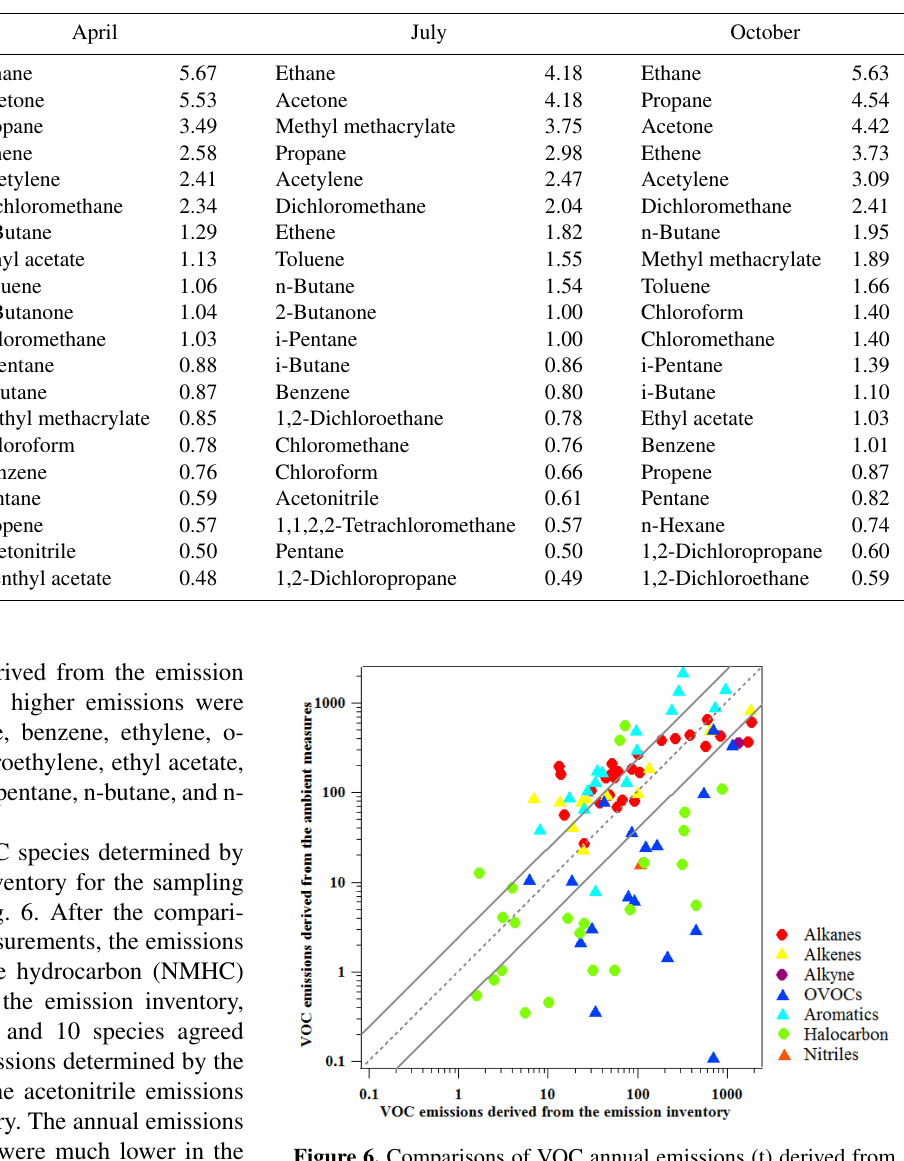
Figure 6. Comparisons of VOC annual emissions (t) derived from the ambient measurements and emission inventory for the PKU